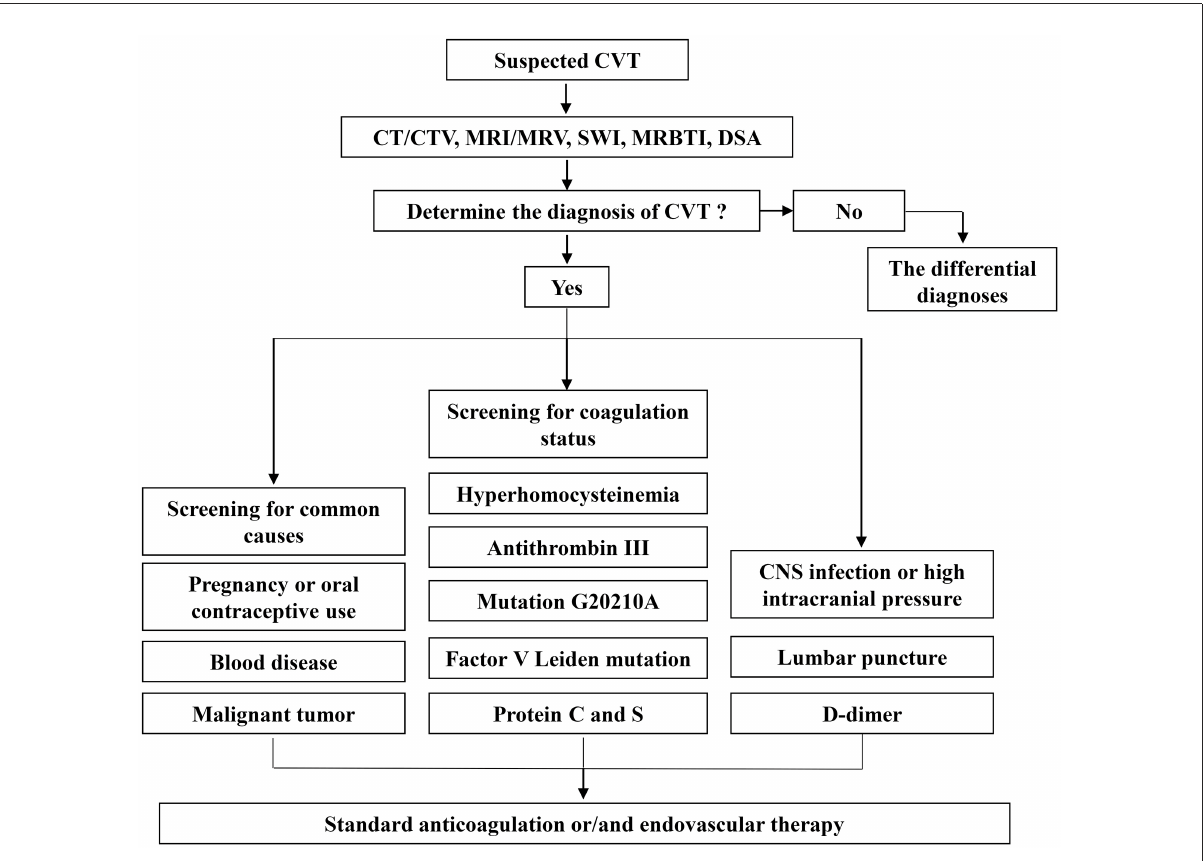
FIGURE2 Clinical diagnosis and treatment of CVT.